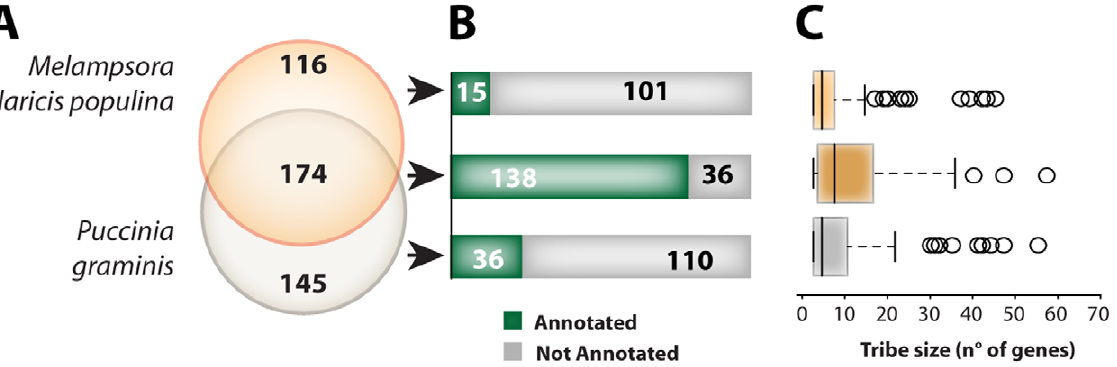
Figure 3. Comparison between core and lineage-specific secretome tribes of at least three proteins in rust fungi. (A) Core tribes (containing proteins from both species of rust fungi) represent forty percent (174 out of 435) of the secretome tribes containing three or more proteins. (B) Core secretome tribes of at least three proteins are enriched in proteins annotated by homology searches whereas lineage-specific tribes often remained non-annotated. (C) Size distribution of core secretome tribes of at least three proteins was shifted towards larger tribes compared to lineage-specific tribes. The same conventions as in Figure 2 were used in the boxplots.